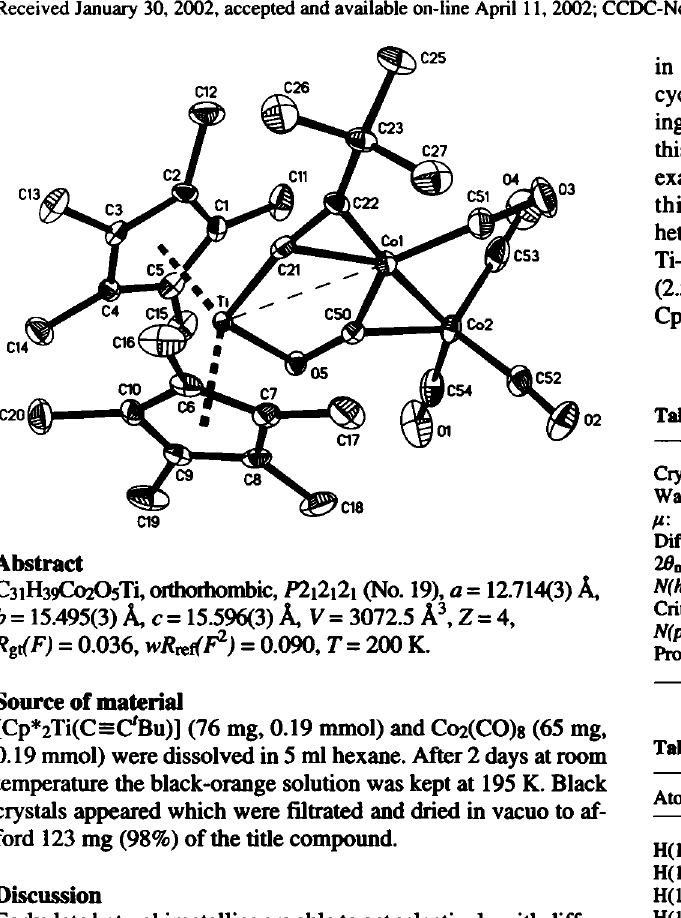
Table 2. Atomic coordinates and displacement parameters (in Â 2